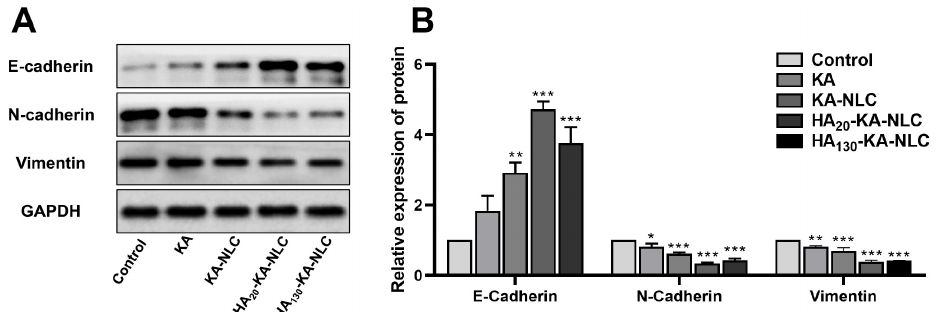
Figure 14. ( A ) The proteins levels of EMT-associated biomarkers untreated or treated with KA, KA- NLC, HA 20 -KA-NLC, and HA 130 -KA-NLC examined by Western blot assay. ( B ) Quantification of E-cadherin, N-cadherin, and Vimentin in A549 cells. The data are presented as the mean ± SD ( n = 3). * p < 0.05, ** p < 0.01, *** p < 0.001.